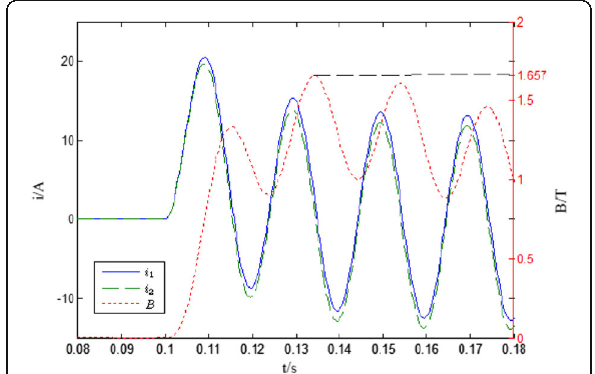
Fig. 13 Waveforms of air-gapped CT ’ s primary current, secondary current and magnetic flux